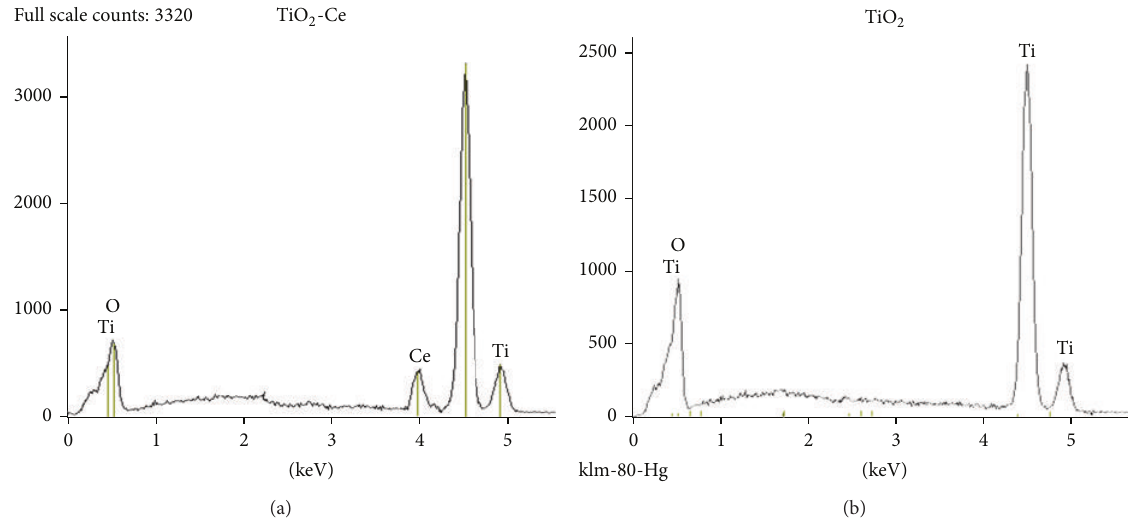
Figure 4: EDX analysis of TiO 2 -Ce doped and TiO 2